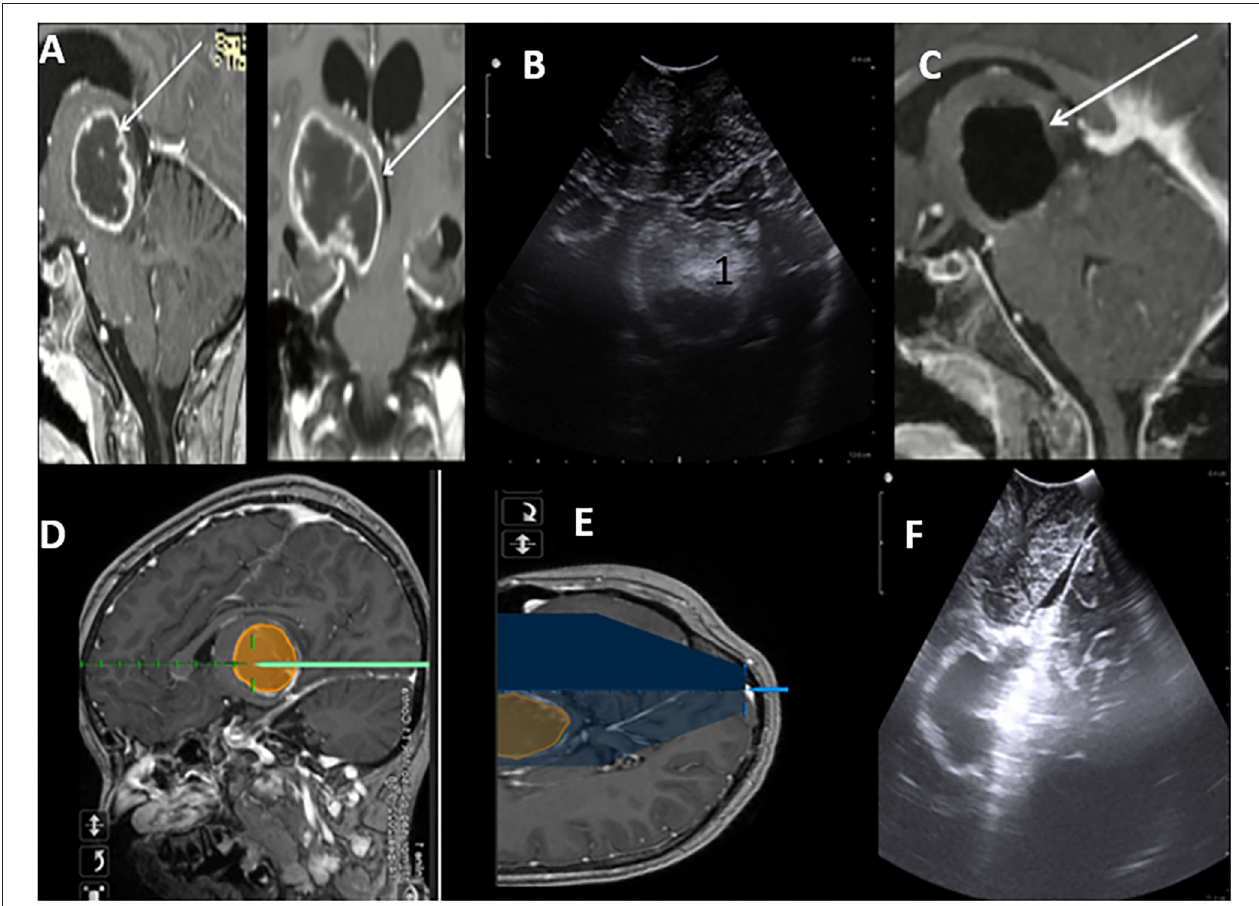
FIGURE 4 | Post Contrast MRI T1WI Sagittal and Coronal sections suggestive of high-grade thalamic glioma (HGG) with cystic central cystic component (A) . Brain lab navigation system depicting trajectory to the lesion (D,E) . iUS Axil section depicting thalamic hyperechoic lesion (B) . Post-resection iUS Sagital section depicting wall of the cavity after complete resection (F) . MRI in concordance with ius showing gross total resection of the HGG (C)